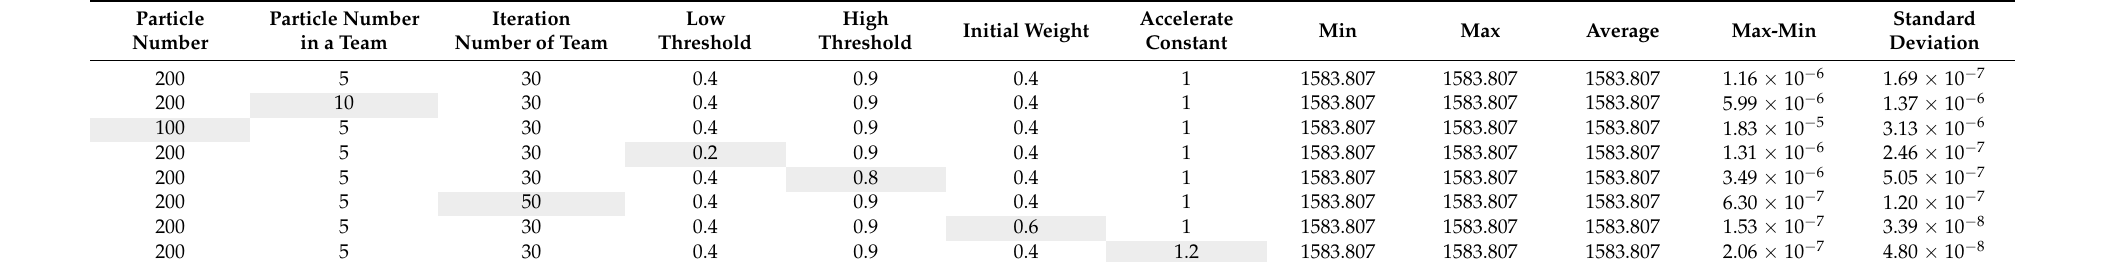
Table 8. Parameter analysis for 3 chillers with cooling load of 2160 RT in Case 3.